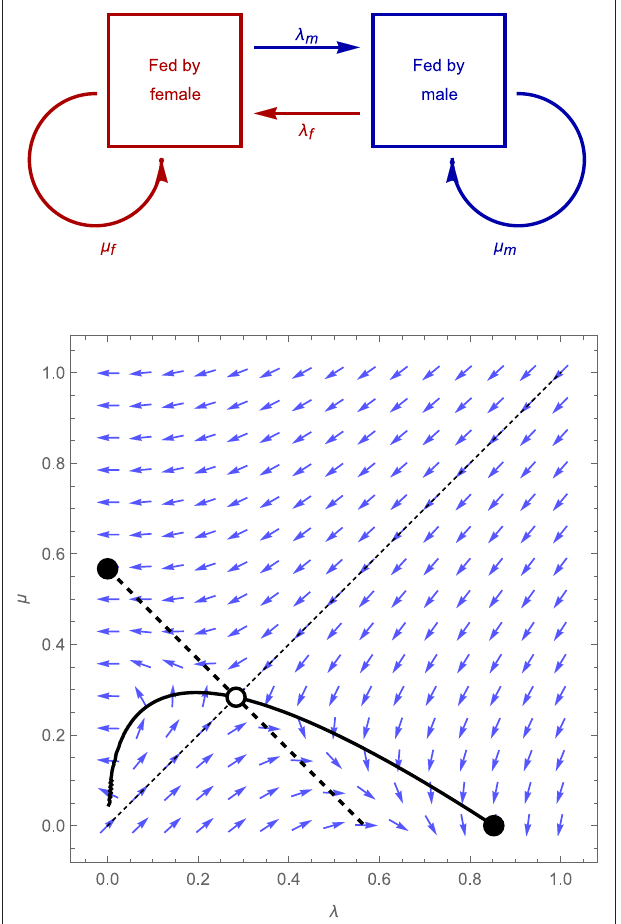
FIGURE 1 | Structure of the model of Johnstone et al. (2014) (upper panel), and the direction of selection for an illustrative case (lower panel) in which λ f = λ m = λ and µ f = µ m = µ , the fitness gained from the current brood is given by f ( x f + x m ) = 1 − Exp ( − x f − x m ), where x f and x m denote mean female and male visit rates, respectively, and the expected fitness a parents gains from future broods is given by g ( x f ) = K x f 2 or g ( x f ) = K – x m 2 . Blue arrows show the direction of selection for a population characterized by particular values of λ and µ , thick curves represent the null-clines for λ (solid curve) and µ (dashed curves), along which the selection gradient for the trait in question is zero, while empty and filled circles denote convergently unstable and stable equilibria, respectively.